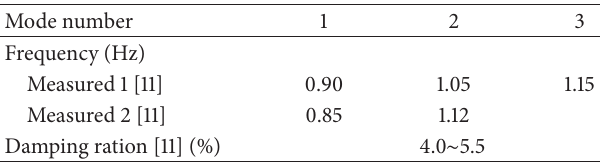
Table 1: Measured frequencies and damping ratio of JZ20-2MUQ platform structure.